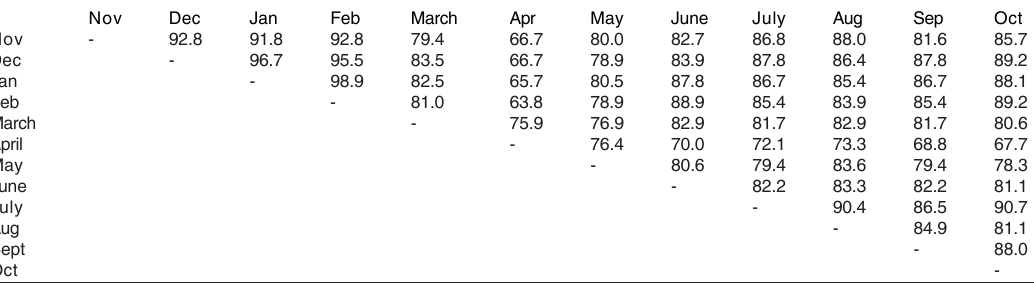
Table 4. Microcrustacea community similarities (Station I)